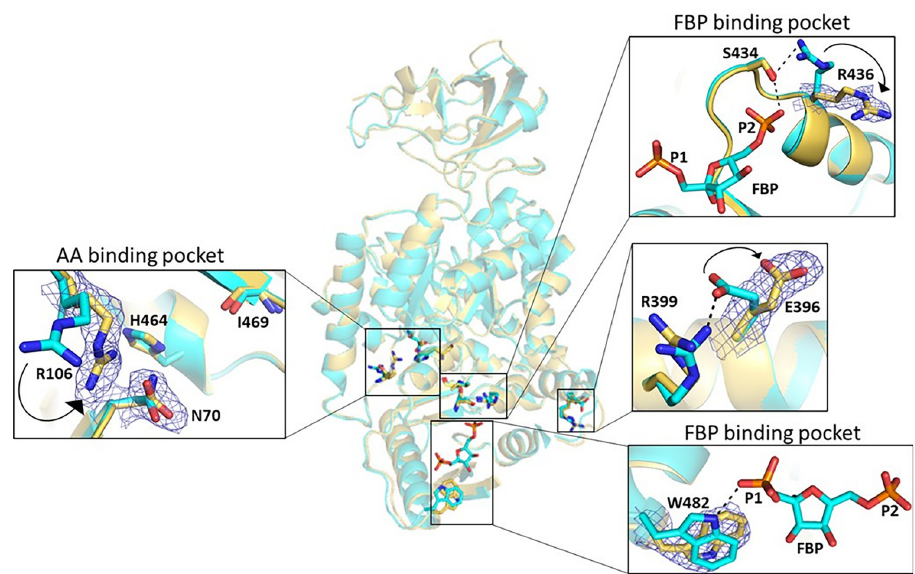
Fig 5. Crystal structure of PKM2 N70D. Superimposition of the AA binding pocket and FBP binding pocket of PKM2 N70D (yellow, PDB: 7L21) and wtPKM2 (cyan, PDB:1T5A) displays structural changes. Left inset: R106 in the AA binding pocket of PKM2 N70D (chain B) showed a shift compared to wtPKM2. D70 superimposed well with N70 of wtPKM2. Top right inset: R436 in the FBP binding pocket of PKM2 N70D (chain D) flipped outwards compared to wtPKM2, thereby breaking the bond with S434, which in turn is connected to FBP. Center right inset: E396 on the monomer interface of PKM2 N70D (chain A) moved outwards, breaking the H-bond with R399. Bottom right inset: W482 in the FBP binding pocket (chain A) rotates by 180˚ along the C β -C (cid:6) bond compared to wtPKM2, which results in breakage of H-bond between the indole ring and FBP. Arrows show the movement of AA sidechains. H-bonds are indicated by dashed lines. O, N, P, and C atoms are in red, blue, orange, and backbone color, respectively. Composite omit 2 F maps (blue mesh) contoured at 1.0 σ were generated for residues D70, R106, R436, E396, and W482. o —F c